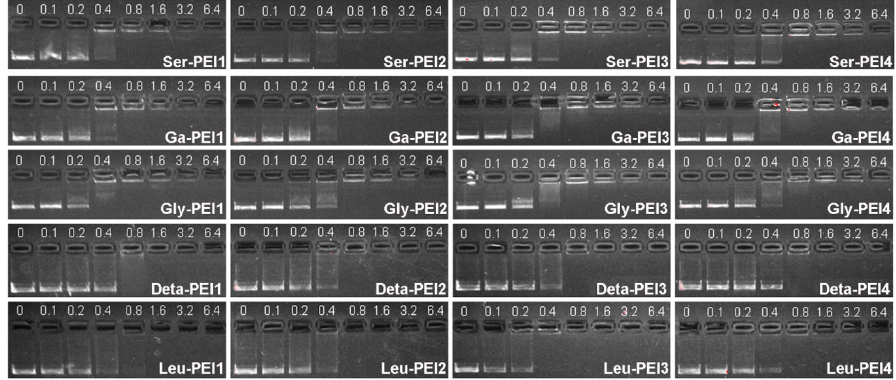
Figure 2. Agarose gel electrophoresis of plasmid DNA (pUC 19) complexed with the cationic polymers at different weight ratios. In each image, the first lane is DNA control.